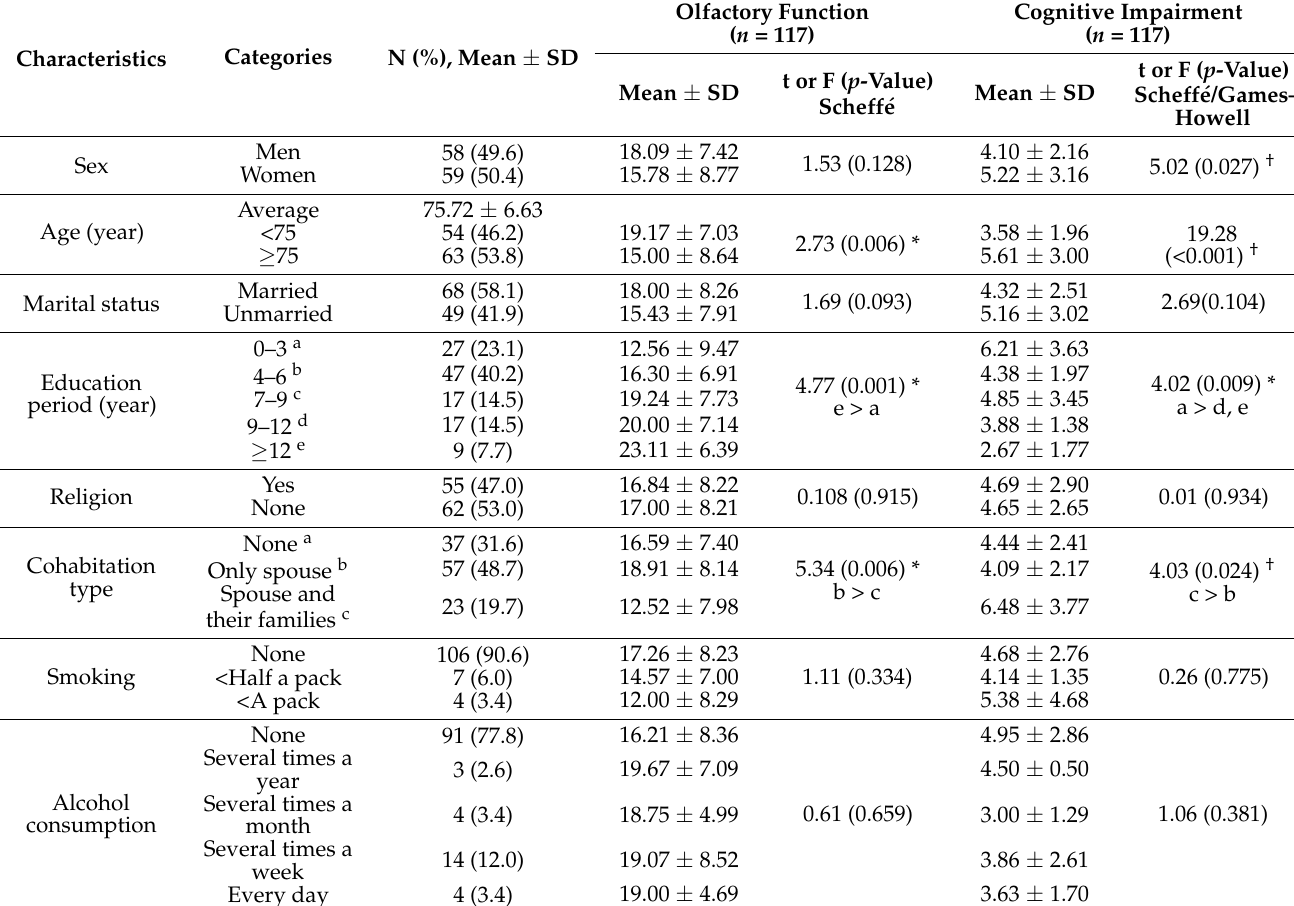
Table 1. Differences in olfactory function and cognitive impairment according to general characteristics.